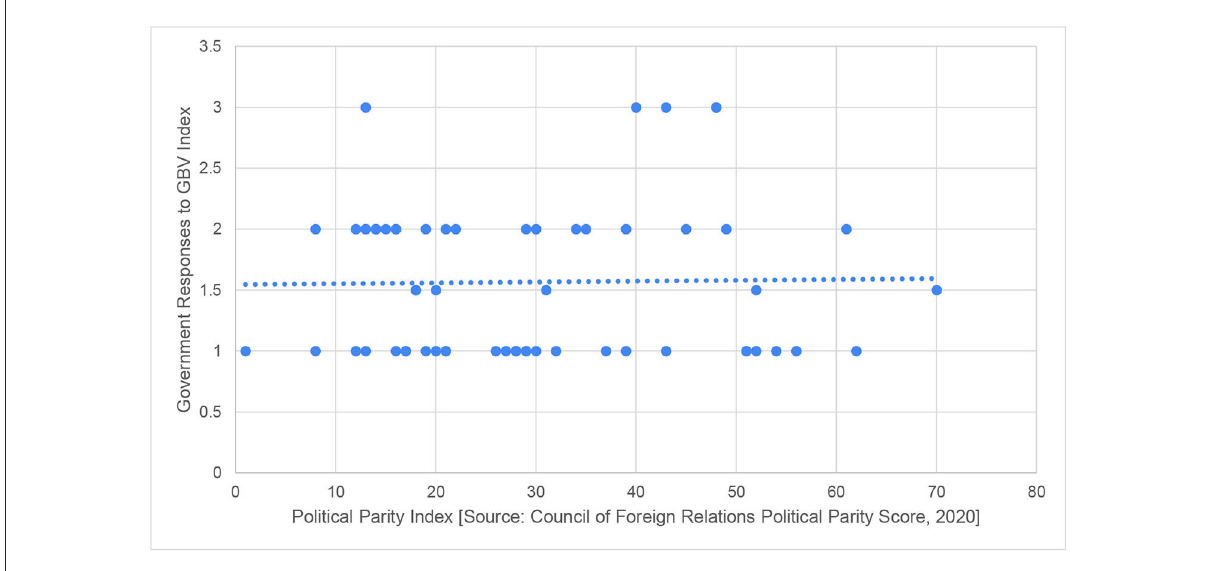
FIGURE4 Comparing political parity index to government responses to GBV during